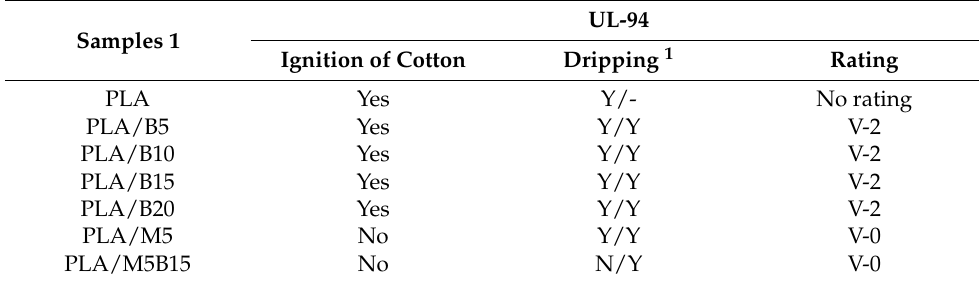
Figure 1. The limiting oxygen index (LOI) results of PLA composites. Table 3. The UL-94 test results of PLA and PLA